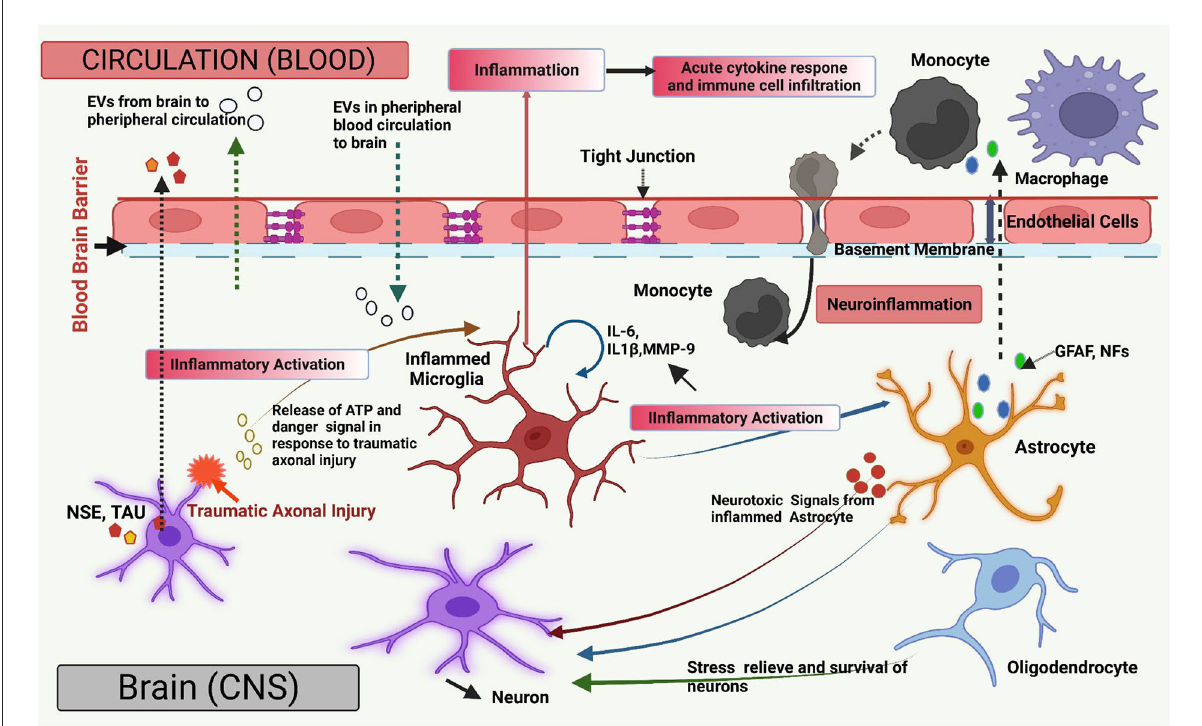
FIGURE1 Overview of the extracellular vesicles (EVs) in brain injury. The diagram illustrates a graphical overview of the EV-mediated pathways and mechanisms that contribute to neuroinflammation and CNS damage (such as Traumatic brain injury; TBI) and are engaged in bidirectional cellular communication via EVs. All major types of CNS cells can send and receive EVs together with their molecular payloads, such as nucleic acids, functional proteins, and lipids molecules. Neuronal insult causes the release of ATP and molecular danger stimulus, which can produce pro-inflammatory EVs by microglia (IL-6, IL-1 β ). Microglial-derived EVs transmit inflammation via pro-inflammatory stimulation of other microglia and astrocytes. Microglial pro-inflammatory EVs can transverse the blood–brain barrier (BBB) to communicate with peripheral receptors upon neuronal absorption. After being stimulated with pro-inflammatory cytokines, astrocytes and endothelial cells generate EVs that cross the BBB and spread neuroinflammation by inducing the acute pro-inflammatory cytokine response, enabling molecular crosstalk between brain cells in the peripheral circulation. EVs, associated with inflamed astrocytes, generate neurotoxic chemicals. Also, EV-associated Astrocyte (Glial Fibrillary acidic protein; GFAP, Neurofilaments; NFs) and neuron-specific proteins (Neuron-specific enolase; NSE, TAU) may be released from damaged neurons due to traumatic axonal injury and enter the blood if BBB integrity is compromised, and their presence may indicate neuronal injury. EVs generated from oligodendrocytes and astrocytes transfer prior protein to a neuron which aids in neuronal stress relief and survival under ischemic and hypoxic conditions. EVs are also involved in the propagation, dissemination, and clearance of abnormal and neurotoxic proteins in neurodegenerative diseases. Figure created with